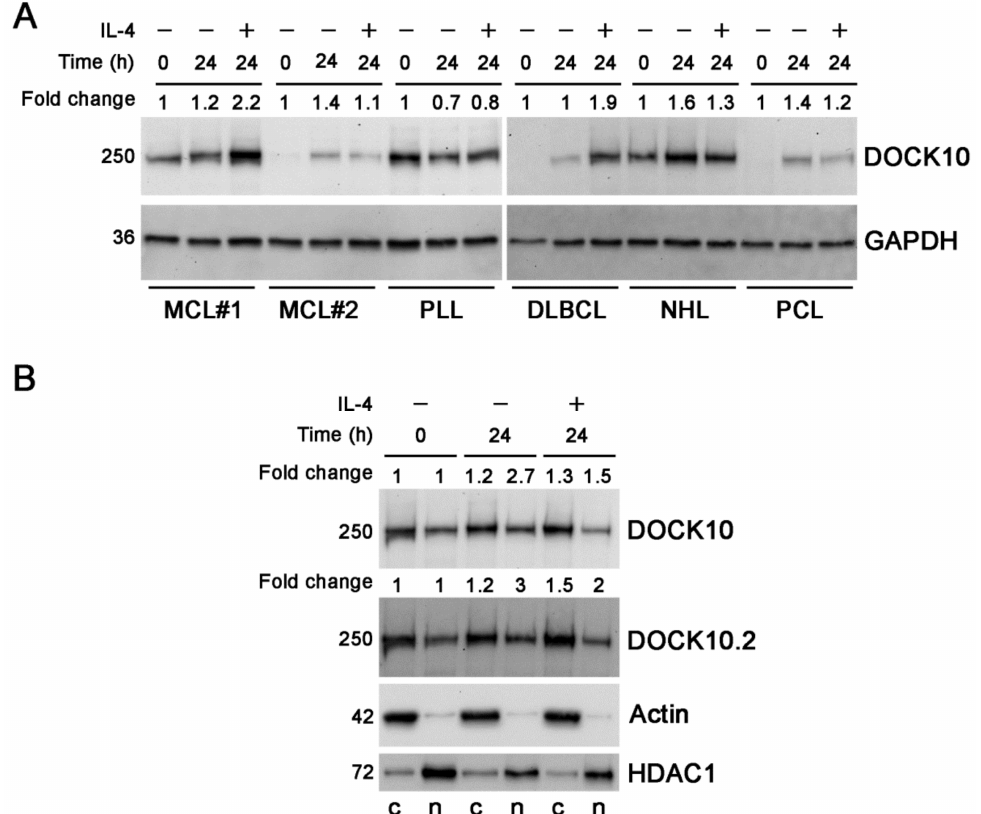
Figure 2. Induction of DOCK10 protein by IL-4 in B-cell lymphoid neoplasms and its distribution between the cytosol and the nucleoplasm in a CLL patient. ( A ) Induction of DOCK10 protein by IL-4 in 6 patients: 2 MCL, 1 PLL, 1 DLBCL, 1 NHL, and 1 PCL. WB analysis of total extracts from each sample before treatment and after 24 h of culture without and with IL-4 using Abs against total DOCK10 (305A) and GAPDH. Fold changes were calculated after normalization with GAPDH in comparison with the T0 sample. ( B ) Distribution of DOCK10 protein between the cytosol and nucleoplasm in a CLL patient. WB analysis of cytoplasmic and nuclear extracts from the sample before treatment and after 24 h of culture without and with IL-4, using Abs against total DOCK10 (305A), the DOCK10.2 isoform, actin, and HDAC1. The fold changes of total DOCK10 and the DOCK10.2 isoform were calculated after normalization by actin for cytosolic levels and by HDAC1 for nuclear levels, in comparison with the respective T0 cytosolic or nuclear fractions. The approximate molecular size of each of the proteins studied, in kDa, is shown to the left of the blots. c, cytosol; n,